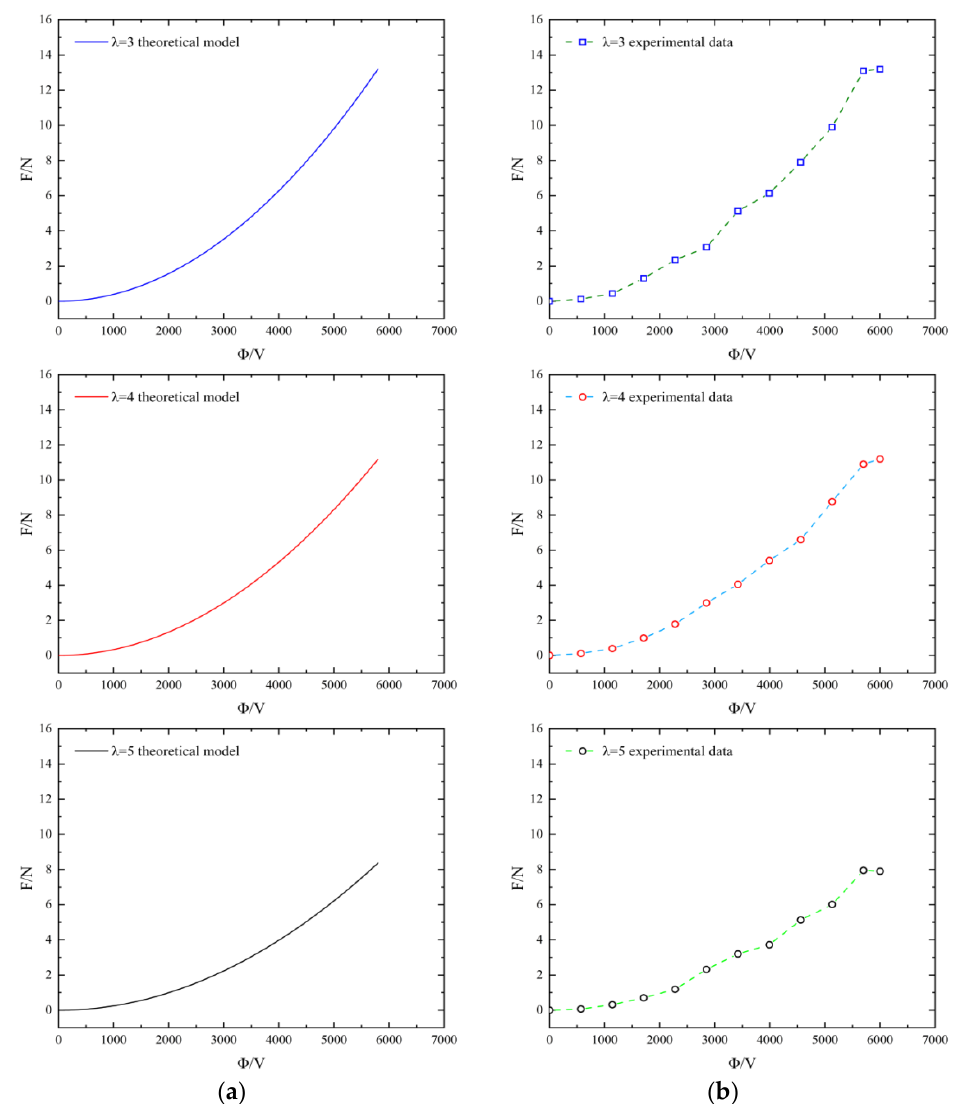
Figure 3. ( a ) The algorithm results after inputting the length, width, and height of the membrane. ( b ) The graphs show the experimental data collected by the sensors, from which it can be seen that the real data and the results simulated by the algorithm are in good agreement.